Question: What direction does the quantity move in — increasing or decreasing?
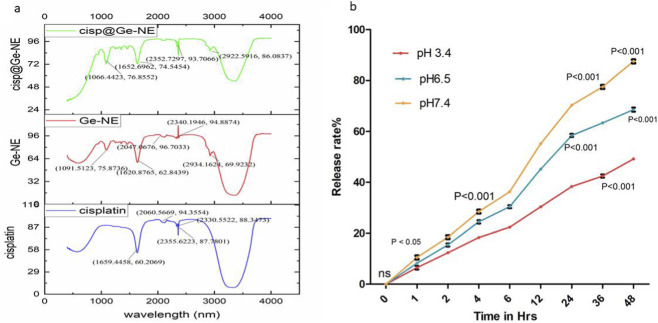
Answer: increasing